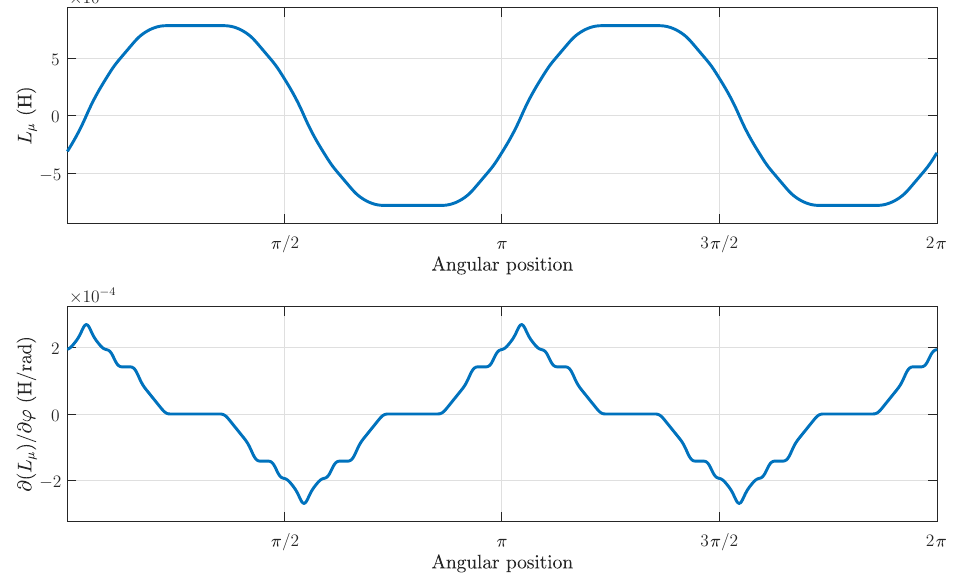
Figure 16. Mutual inductance between a stator winding and a rotor loop of the tested machine as a function of the rotor position ( top ), and its angular derivative ( bottom